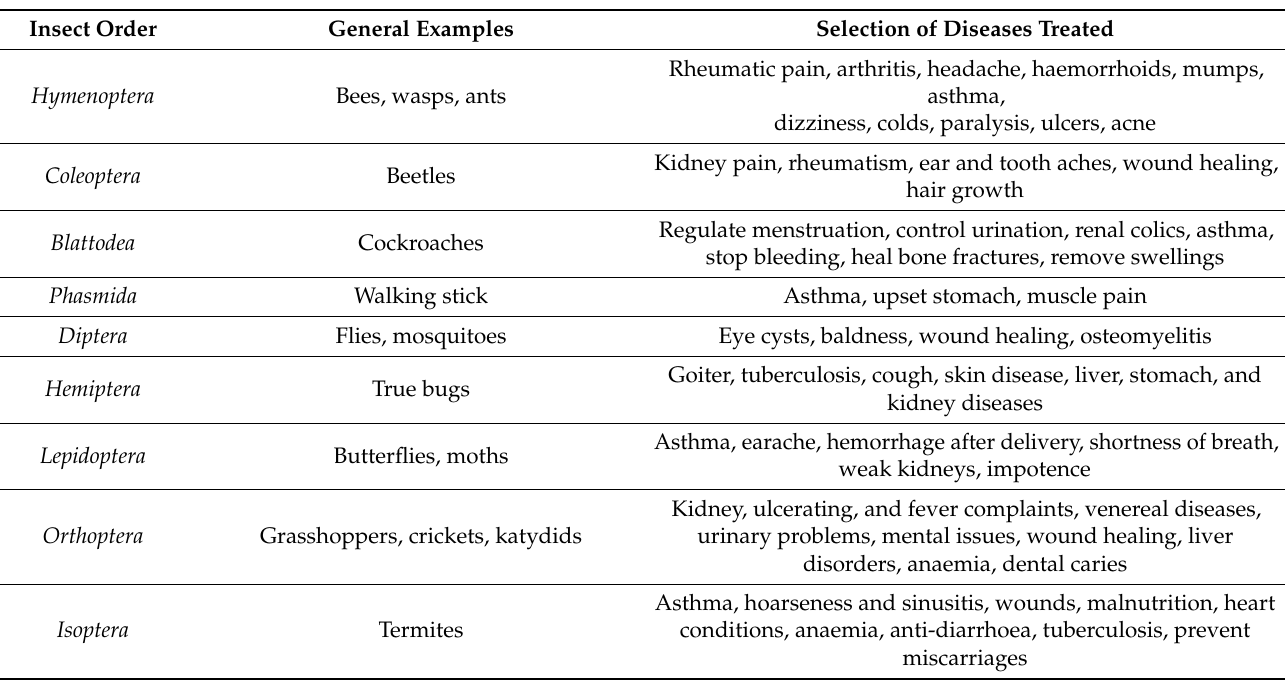
Table 2. General overview of insect orders and their use in traditional medicine (Adapted from [36,38,40]. Insect Order General Examples Selection of Diseases